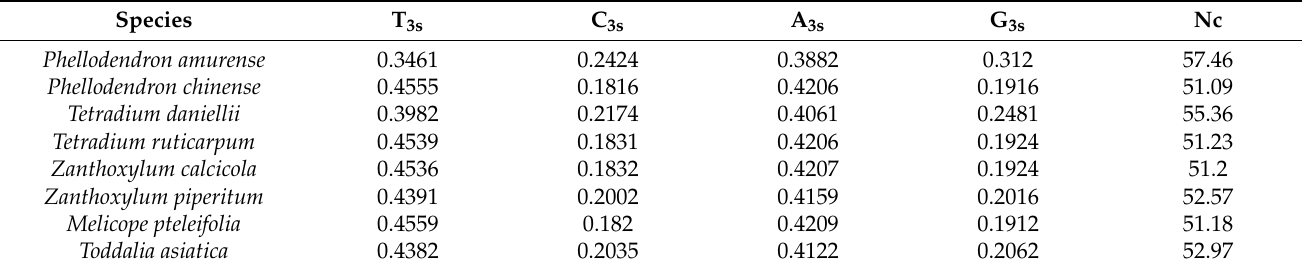
Table 2. Indexes of the codon use of the eight chloroplast